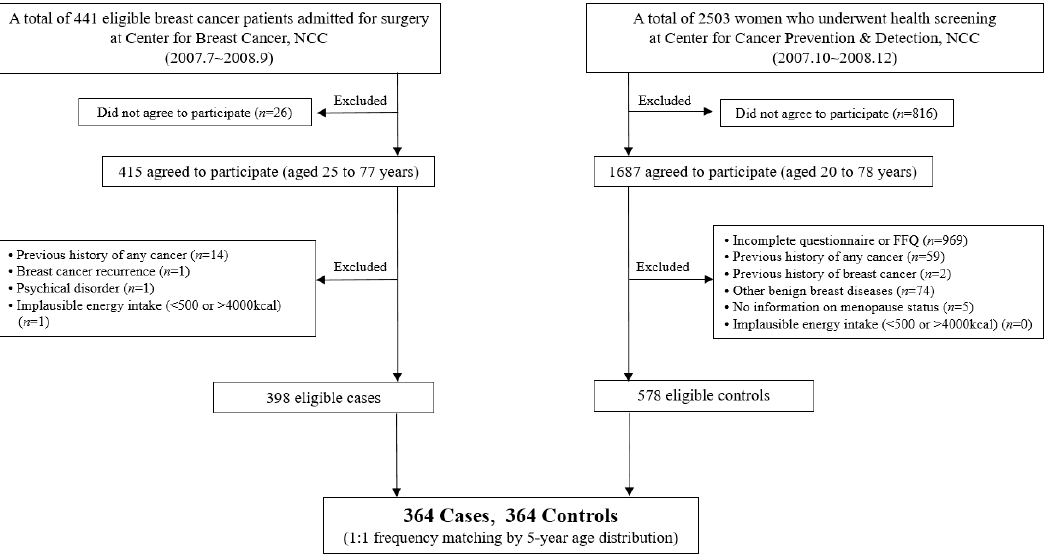
Figure 1. Flow chart of the study population selection.